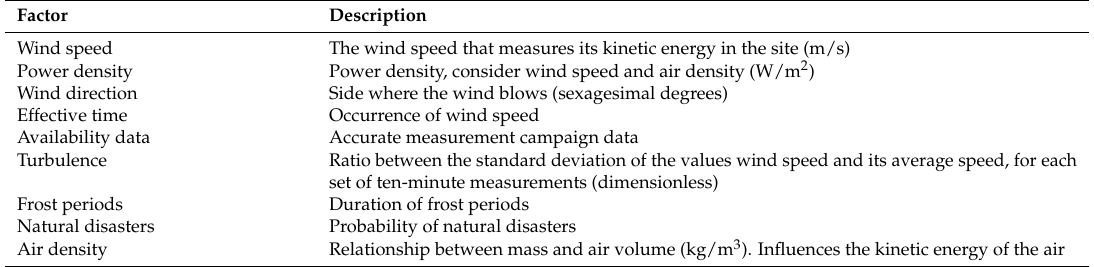
Table 1. Description of factors involved in the optimal location in the wind farms. Climate category.